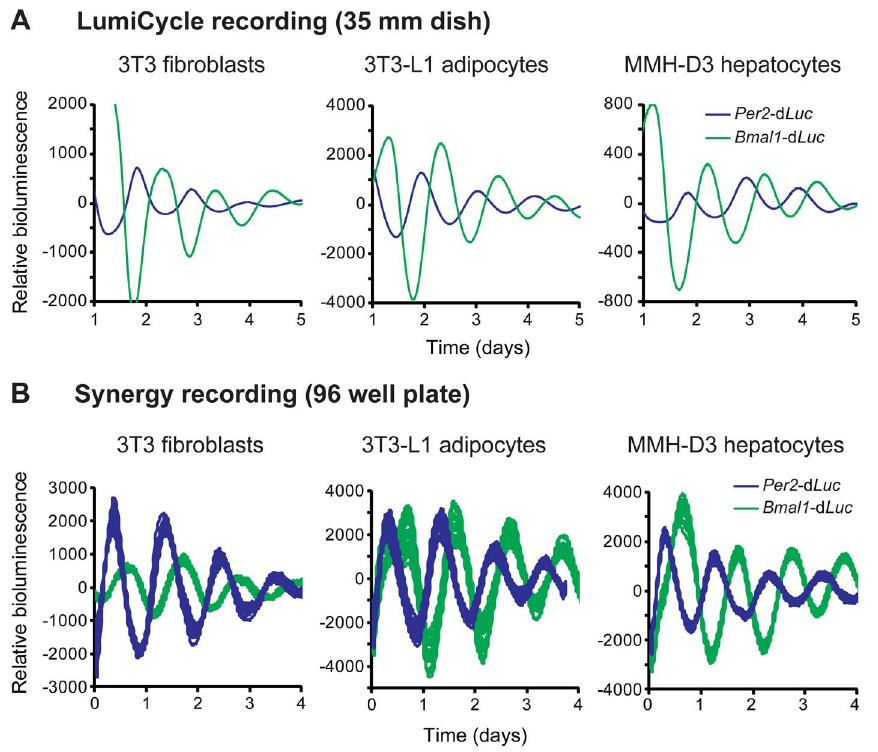
Figure 1. Fibroblasts, adipocytes, and hepatocytes display bioluminescence rhythms. (A) Representative bioluminescence rhythms of reporter cells recorded in a LumiCycle luminometer on 35 mm dishes. Reporter cells were generated via lentiviral infection of either Per2 -d Luc or Bmal1 -d Luc luciferase reporter, and infected cell populations were recorded in a LumiCycle. Baseline-subtracted bioluminescence data of both reporter lines are plotted together to show the expected, approximately anti-phasic reporter expression for each cell type. (B) Representative bioluminescence rhythms of homogenous clonal cell lines recorded in a Synergy microplate reader on 96 well plates. Baseline-subtracted bioluminescence data of selected clonal lines representing both reporter types are plotted together to show anti-phasic reporter expression for each cell type. High reproducibility is illustrated by showing overlapping traces from 24 of the 96 wells for each reporter. The period lengths are highly consistent (mean 6 SD, n=24 for each line): 3T3 Per2 -d Luc , 25.62 hr 6 0.21; 3T3 Bmal1 -d Luc , 26.72 hr 6 0.31; 3T3-L1 Per2 -d Luc , 24.60 hr 6 0.32; 3T3-L1 Bmal1 -d Luc , 25.01 hr 6 0.19; MMH-D3 Per2 -d Luc , 24.49 hr 6 0.18; MMH-D3 Bmal1 -d Luc , 25.33 hr 6 0.13.